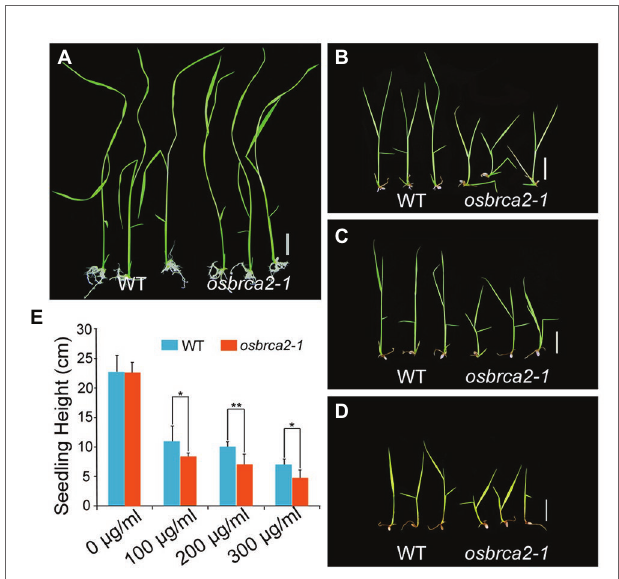
FIGURE 9 | Osbrca2-1 mutants are sensitive to mitomycin C (MMC). Phenotypes of wild-type and osbrca2-1 seedlings growth in ½ MS medium at different MMC concentrations with 0 μ g/ml (A) , 100 μ g/ml (B) , 200 μ g/ml (C) , and 300 μ g/ml (D) . (E) Statistical analysis of the height of wild-type